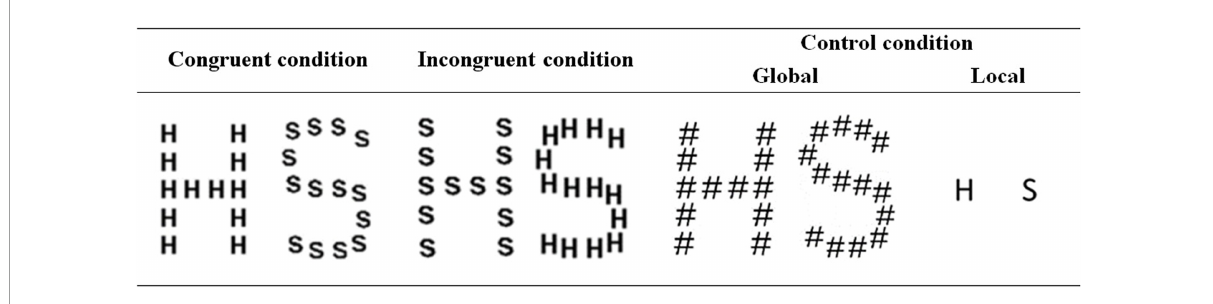
FIGURE1 Stimuli presented in each condition for the global/local Navon identification